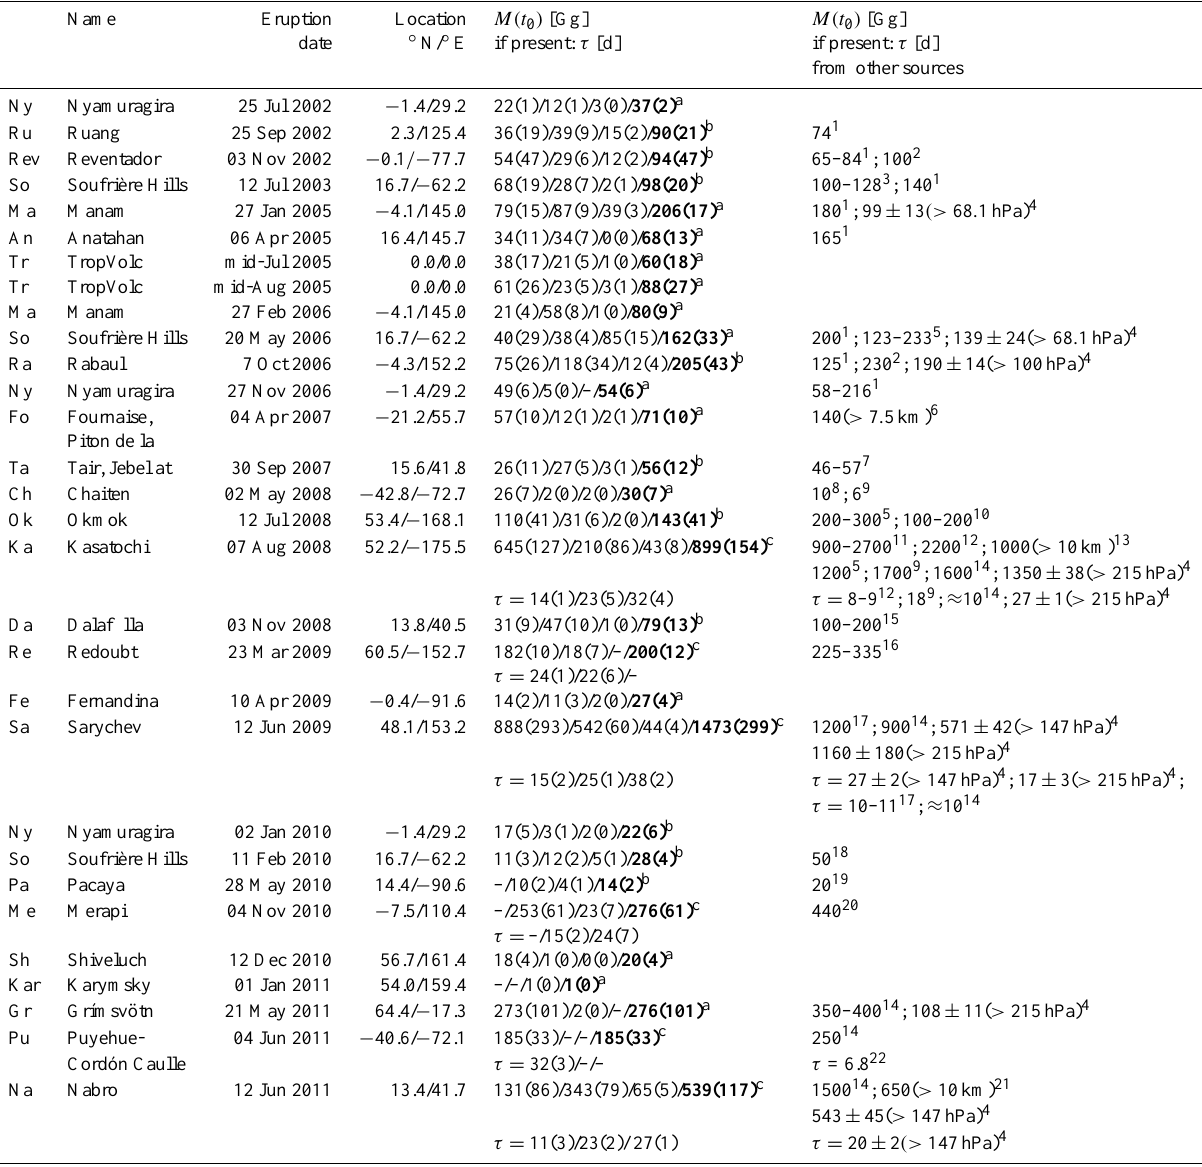
Table 3. Volcanic eruptions observed in MIPAS measurements. General data of volcanoes are obtained from http://www.volcano.si.edu. “TropVolc” indicate unidentified sources at low tropical latitudes. M(t 0 ) are the resulting emission masses of SO 2 from the exponential fit (see text for details). Values of M(t 0 ) are given for altitude ranges 10–14/14–18/18–22/ 10–22 km. “ τ = ” in column M(t 0 ) indicates that a fit of the lifetime was possible with the values in days given for the altitude ranges 10–14 / 14–18 / 18–22km. Values in brackets indicate estimated